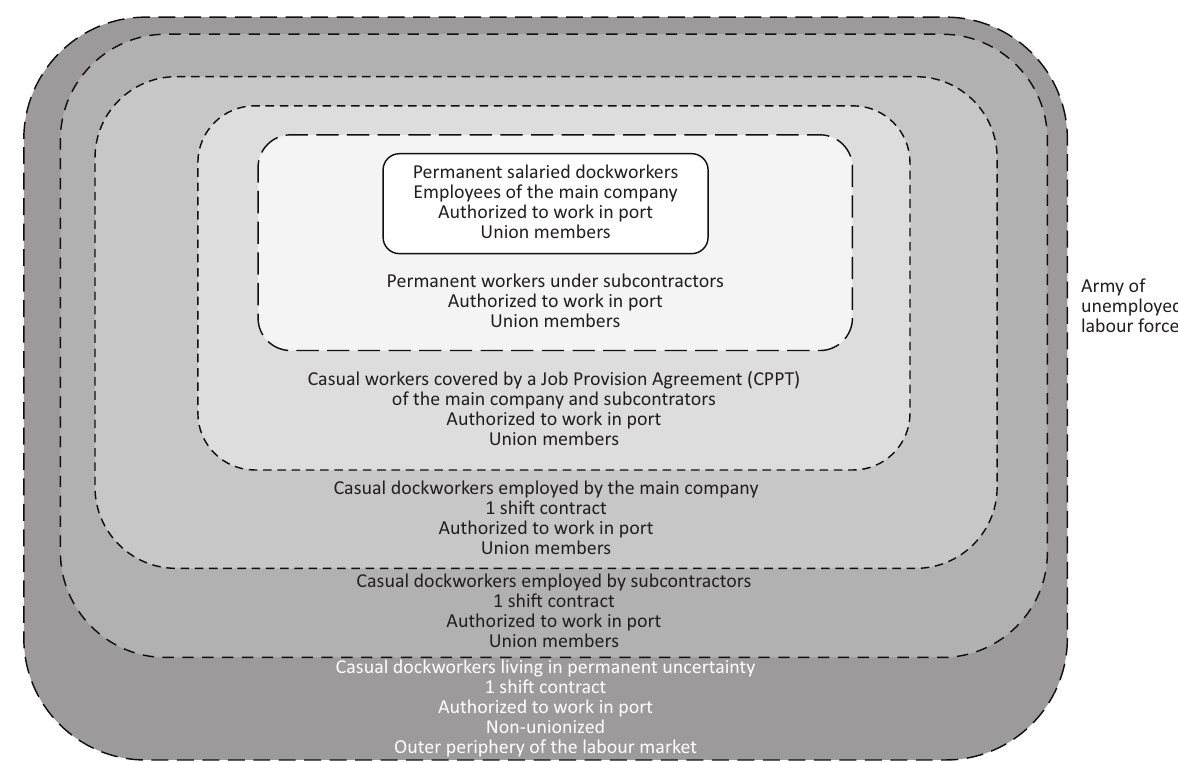
Figure 9. Multiple labour positions in Chilean ports. Source: Own